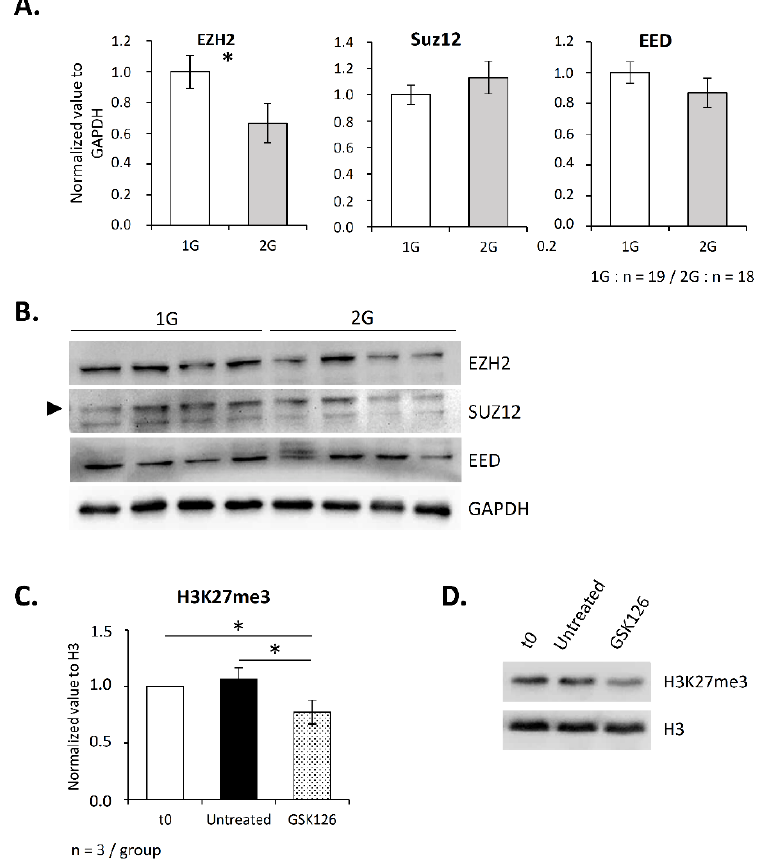
Figure 4. EZH2 is downregulated in the thymus after three weeks spent at 2 × g and regulates H3K27 methylation in thymocytes. ( A , B ) Expression of PRC2 components (EZH2, Suz12 and EED) studied by Western blotting. ( A ) Relative expression of EZH2, Suz12 and EED normalized to GAPDH. ( B ) Representative Western blots obtained with four mice in each group. Arrow indicates Suz12 protein. ( C , D ) To evaluate the contribution of EZH2 activity to the H3K27me3 level in the thymus, thymocytes were exposed, or not, to the specific inhibitor GSK126 at a concentration of 2 µM for 10 h, and histones were extracted to perform Western blots. Here, ‘t0’ indicates H3K27me3 level in thymic cells before treatment. ( C ) Histogram presenting the relative expression of H3K27me3 normalized to H3. ( D ) Western blot representative of three independent experiments. Data are mean ± SD of three independent experiments. ANOVA was used to reveal statistically significant differences. * p < 0.05.